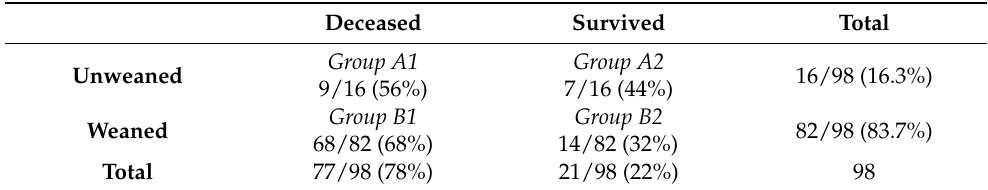
Table 1. Subtyping into groups according to roe deer age (unweaned or weaned) and hospitalisation outcome (deceased or survived).